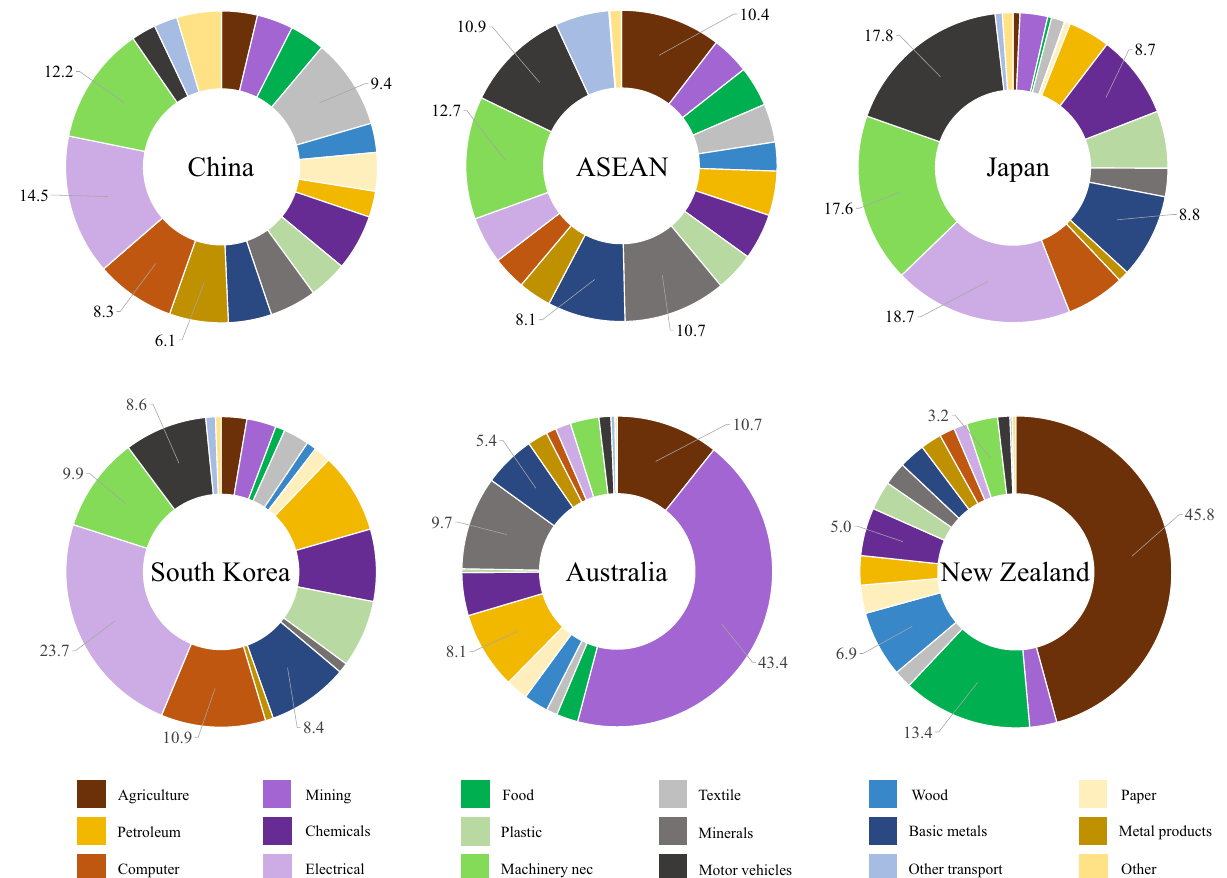
Fig. 5 Sectoral contribution to CO 2 emissions in trade. The pie charts present for the Regional Comprehensive Economic Partnership (RCEP) members the sectoral contribution to their CO 2 emission changes caused by trade changes (Supplementary Table 12). ASEAN denotes the Association of Southeast Asian Nations, but Laos and Myanmar are not included due to data unavailability. The sector classi fi cation is the same as in Fig. 2, but here we